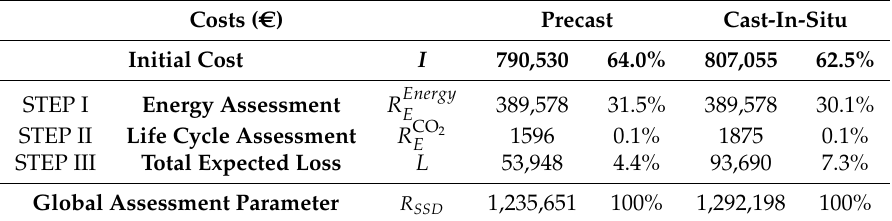
Table 8. Calculation of the Global Assessment